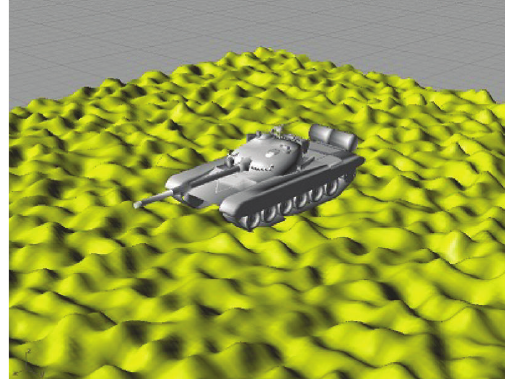
F 5: e 3D geometrical model of a tank above a Gaussian rough